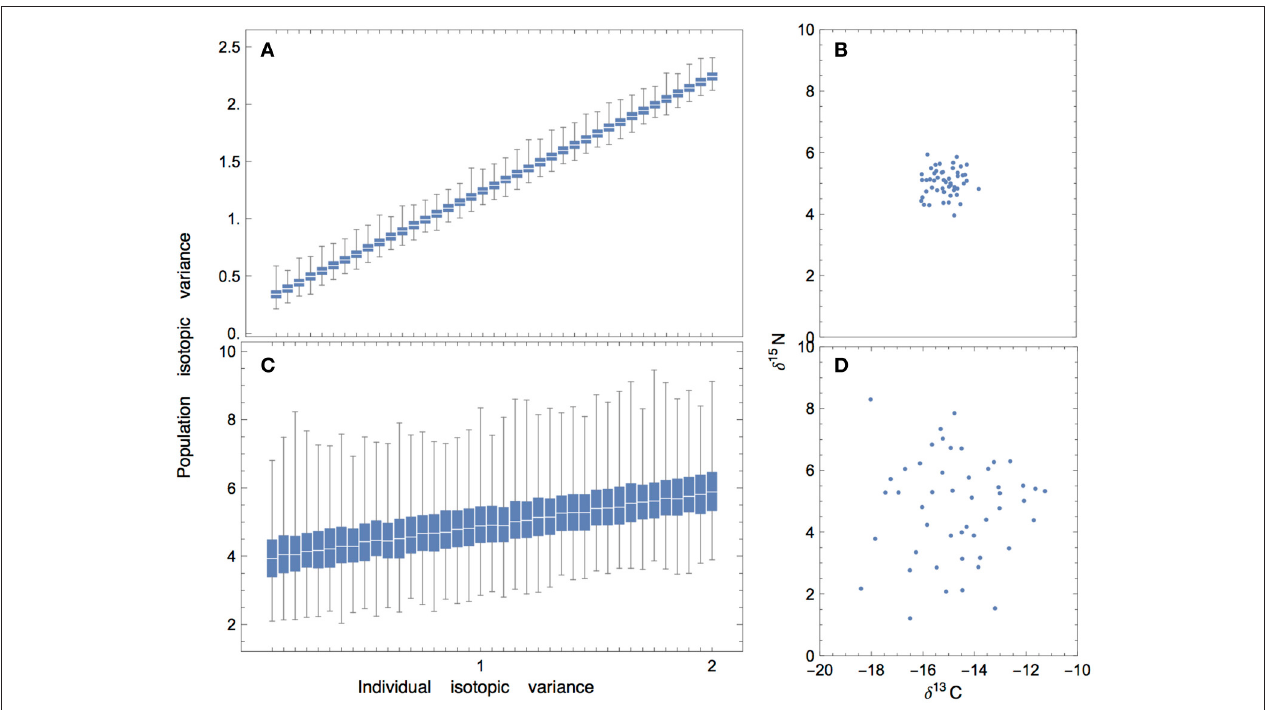
FIGURE 9 | Population isotopic variance vs. individual isotopic variance where mean isotope values of individuals are randomly drawn from a Normal distribution (50 individuals per population; 1000 replicates), and individuals are assumed to have the same variance. (A,B) When the mean values of individuals are randomly drawn from a normal distribution with low variance, there is a linear relationship between individual-level and population-level isotopic variance. (C,D) When the mean values of individuals are randomly drawn from a normal distribution with high variance, the relationship becomes masked by